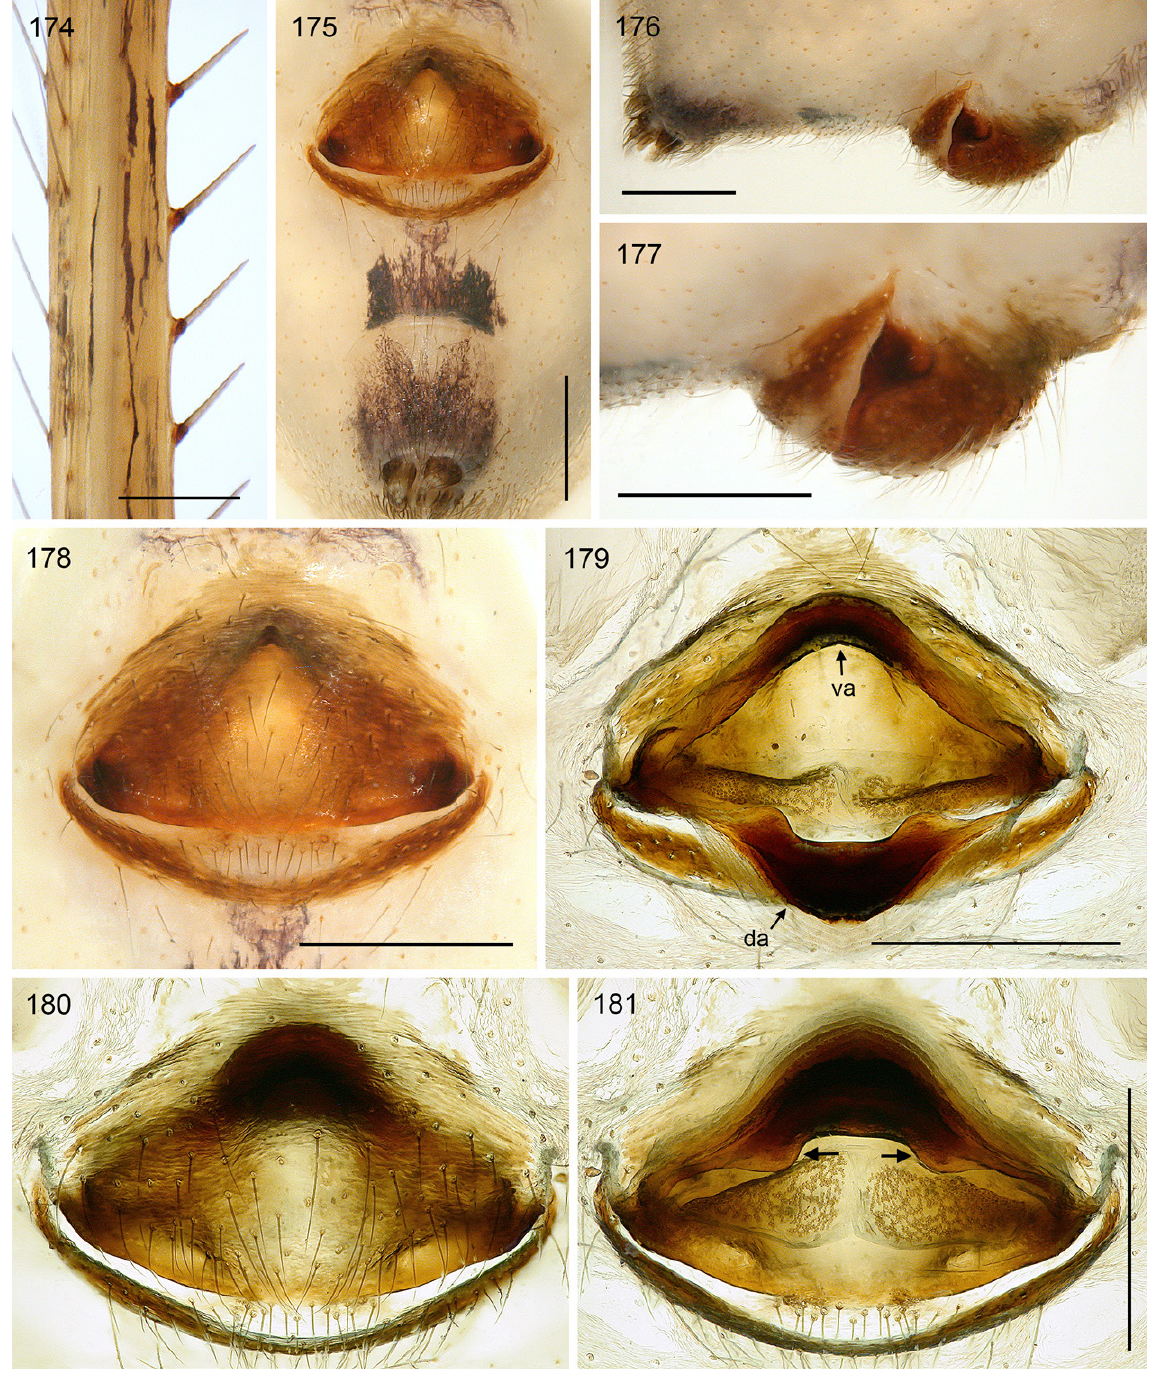
Figs 174–181. Maghreba amezyan gen. et sp. nov.; male and female from Morocco, between Lakhssas and Bouizakarne (ZFMK Ar 22353, AR 22354). 174 . Male right femur 1, retrolateral view. 175– 178 . Female abdomen and epigynum, ventral and lateral views. 179–181 . Cleared female genitalia, dorsal view with dorsal arc tilted backwards, ventral view, and regular dorsal view; arrows: posterior processes of dorsal arc. Abbreviations: da = dorsal arc; va = ventral arc. Scale bars: 174 = 0.3 mm; 175–181 = 0.5